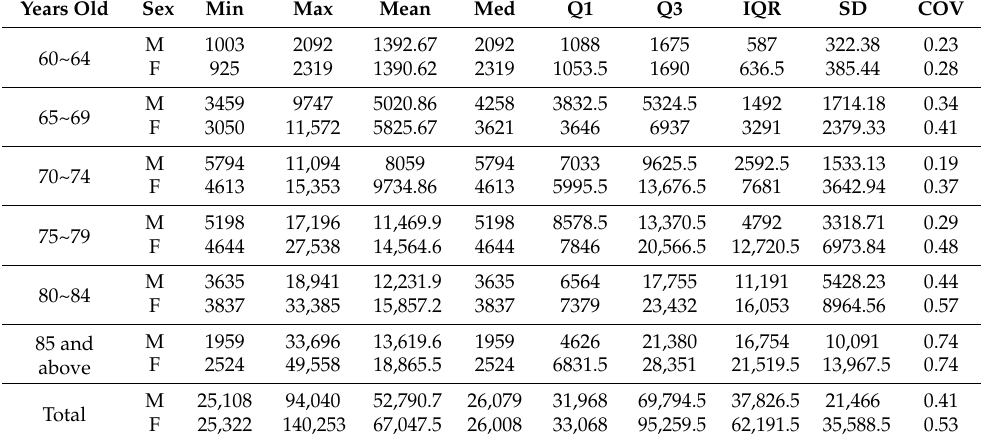
Table 1. Descriptive statistics for dementia patients in Taiwan from 1997 to 2017.